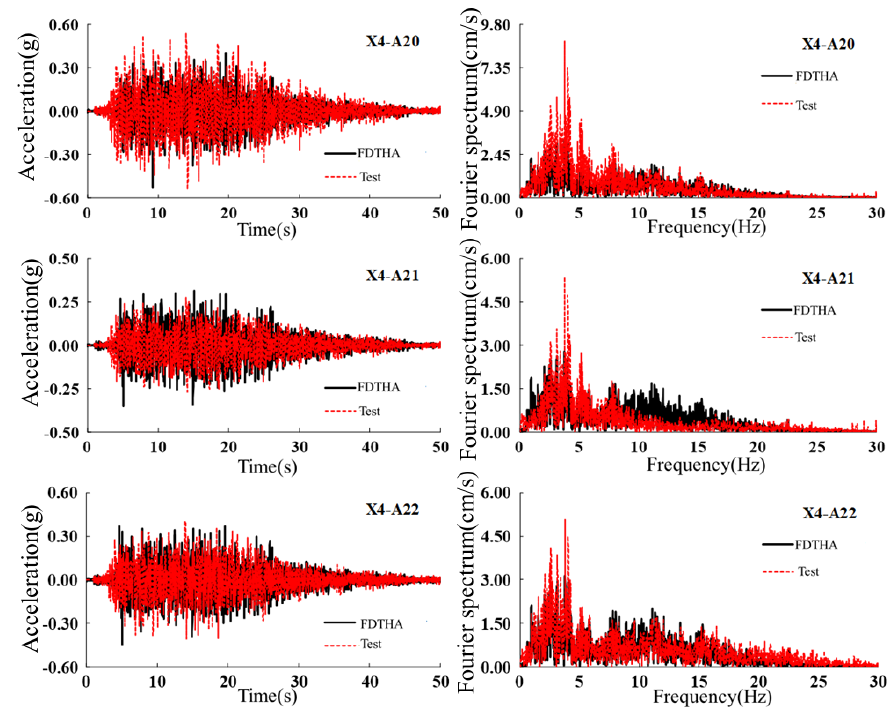
Figure 14. Time-history analysis and acceleration response of model structure in the shaking table